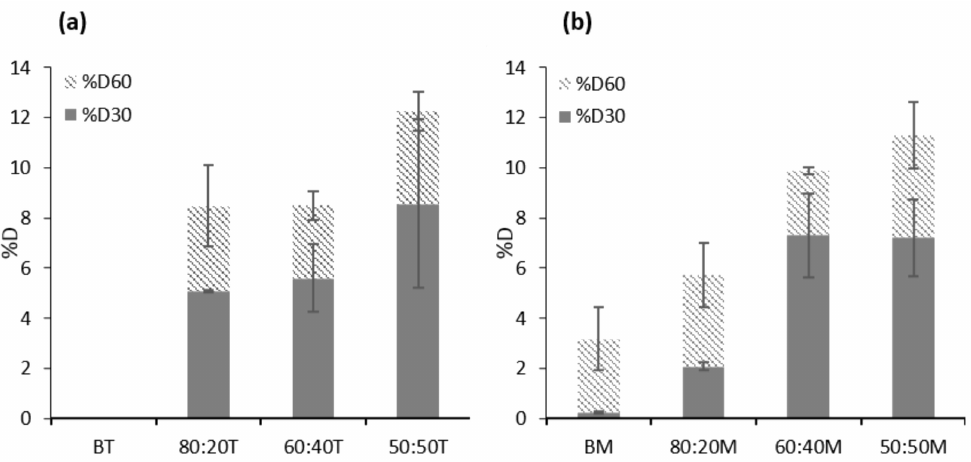
Figure 7. Percentage of biodegradability of ( a ) TDI LWS-PU foams and ( b ) MDI LWS-PU foams after 30 days (% D 30 ) and 60 days (% D 60 ).